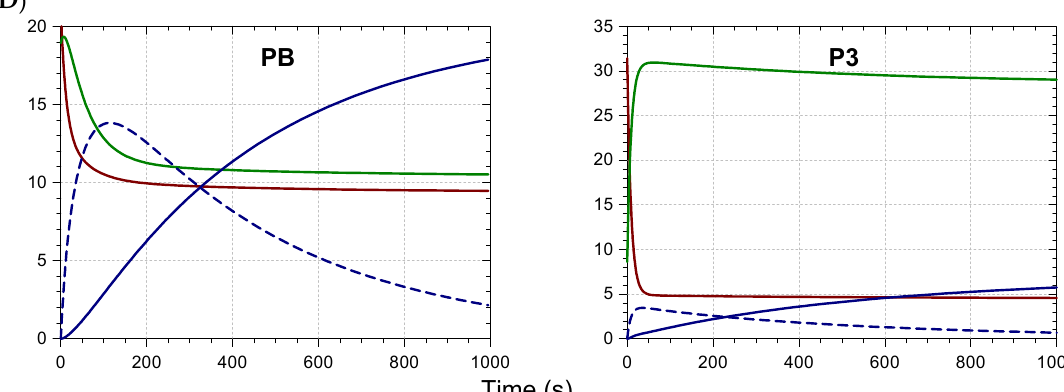
Figure 3. Iron–anthocyanin binding in a pH 4.24 acetate buffer (successive addition of pigment (40 µM) and Fe 2+ (1 equiv.)), Left: Pigment B; right: Pigment 3. Simplified schemes are provided as a reminder of the key structural differences. ( A ) Spectral monitoring at 530 nm (free pigment, ▬ ) and at 670 nm (iron complex, ▬ ). ( B ) Control in the absence of iron (solid lines are the result of the curve-fitting procedure). ( C ) Spectra at time zero ( ▬ ), after ca. 1 min ( ▬ ) and at the end of the kinetic run ( ▬ ). ( D ) Time dependence of the species distribution: free colored forms ( ▬ ); free colorless forms ( ▬ ); Fe 2+ complex ( ▬ ▬ ); Fe 3+ complex ( ▬ ).